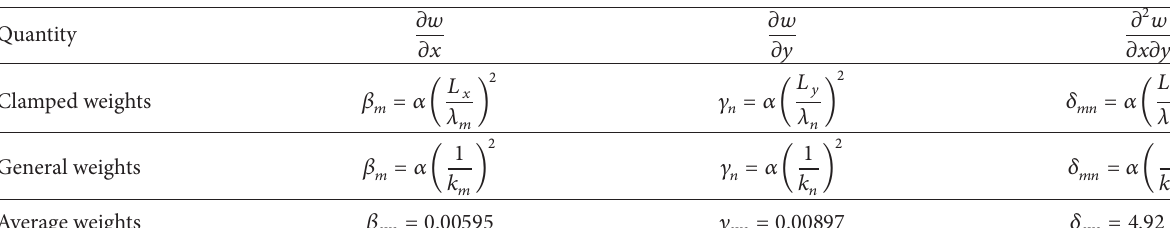
Table 1: Expressions for the weights in WSSG. The average weights shown were calculated using the geometry described in Table 2. Quantity